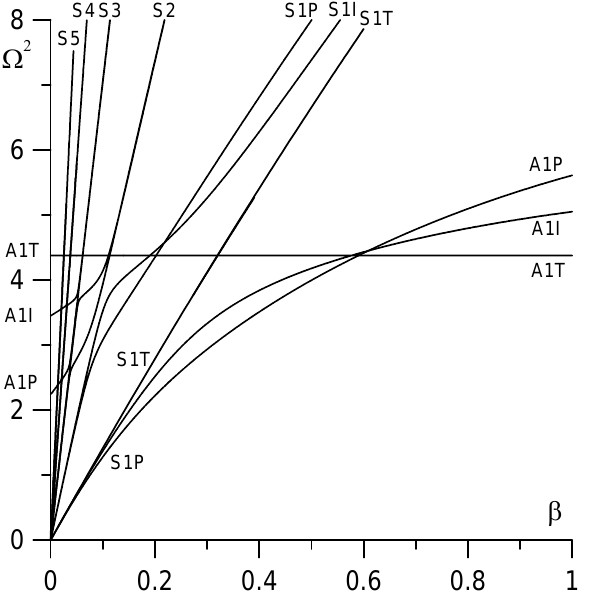
Fig. 3. Third order even eigenfunctions for α = 10, β = 0 . Fig. 2. Dependence of spectrum on beta and polarization for per- fect conductivity ( δ = 0 ) . Horizontal and near-horizontal lines cor- respond to Alfv´en modes; lines running through the origin corre- spond to slow magnetosonic modes. Captions near the curve indi- Figure 3. Third order even eigenfunctions for 10 =α , 01.0 =β . cate a type of eigenmode (“A” – Alfv´en mode, “S” – slow magne- Figure 2. Dependence of spectrum on beta and polarization for perfect conductivity ( 0 =δ ). tosonic mode), the number of the eigenmode and the polarization of Horizontal and near-horizontal lines correspond to Alfvén modes; lines running through the eigenmode (“P” – poloidal ( λ = 0), “T” – toroidal ( λ →∞ ), “I” – intermediate ( λ = 1); absent for higher-order slow magnetosonic origin correspond to slow magnetosonic modes. Captions near the curve indicate type of modes due to a lack of space). eigenmode (“A” — Alfvén mode, “S” — slow magnetosonic mode), number of eigenmode and polarization of eigenmode (absent for higher-order slow magnetosonic modes due to lack of space).